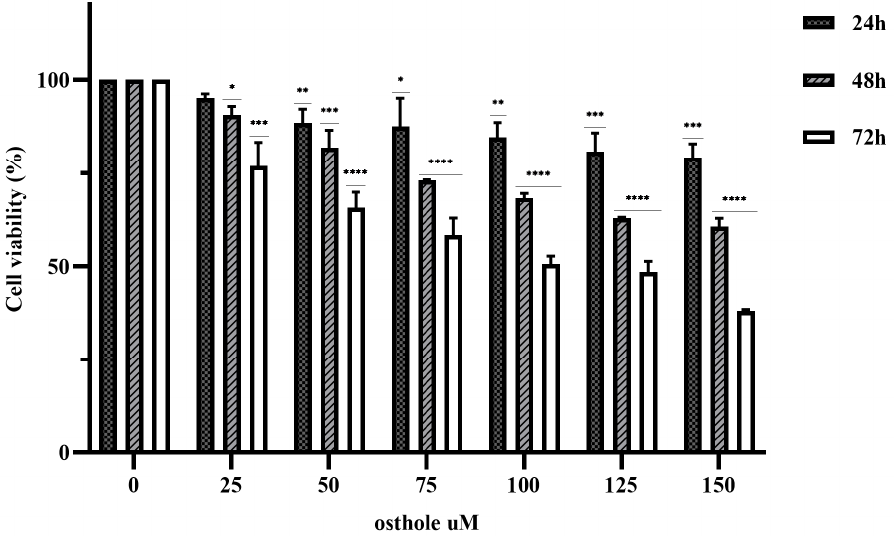
Figure 2. Osthole (OST) inhibits the proliferation of 4T1 cells. 4T1 cells were incubated with OST (0, 25, 50,75, 100, 125, and 150 µ M) for 24, 48, and 72 h. Cell viability was determined in an MTT assay. Compared to that in the control group, Mean ± SD, N = 3, * p < 0.05, ** p < 0.01, *** p < 0.001, **** p < 0.0001.